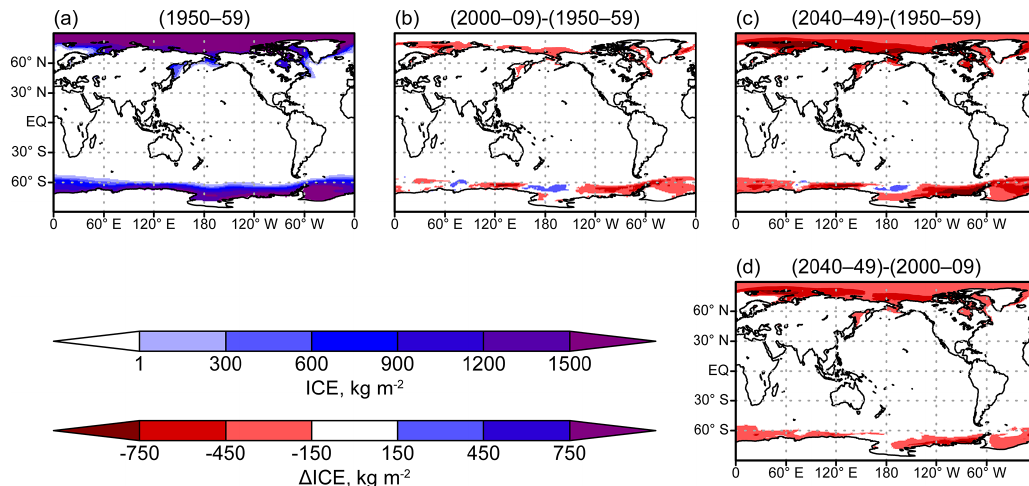
Figure 2. Same as Fig. 1 but for sea ice mass (ICE) in kgm − 2 .